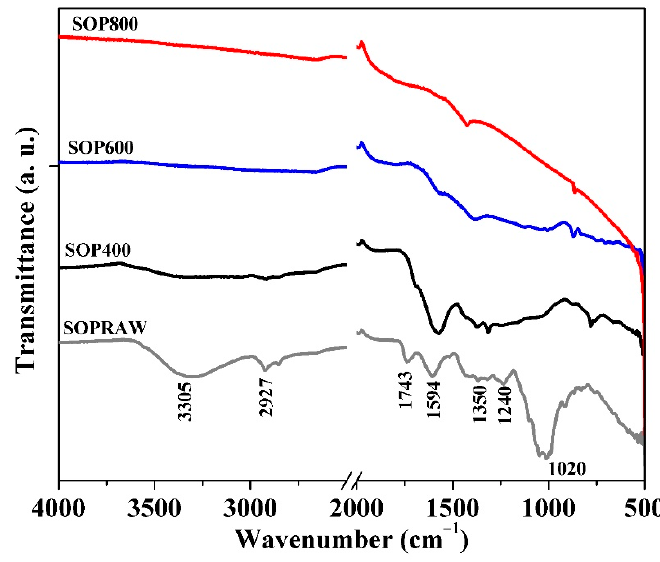
Figure 2. FTIR spectra of SOPRAW and SOP400, SOP600, and SOP800.